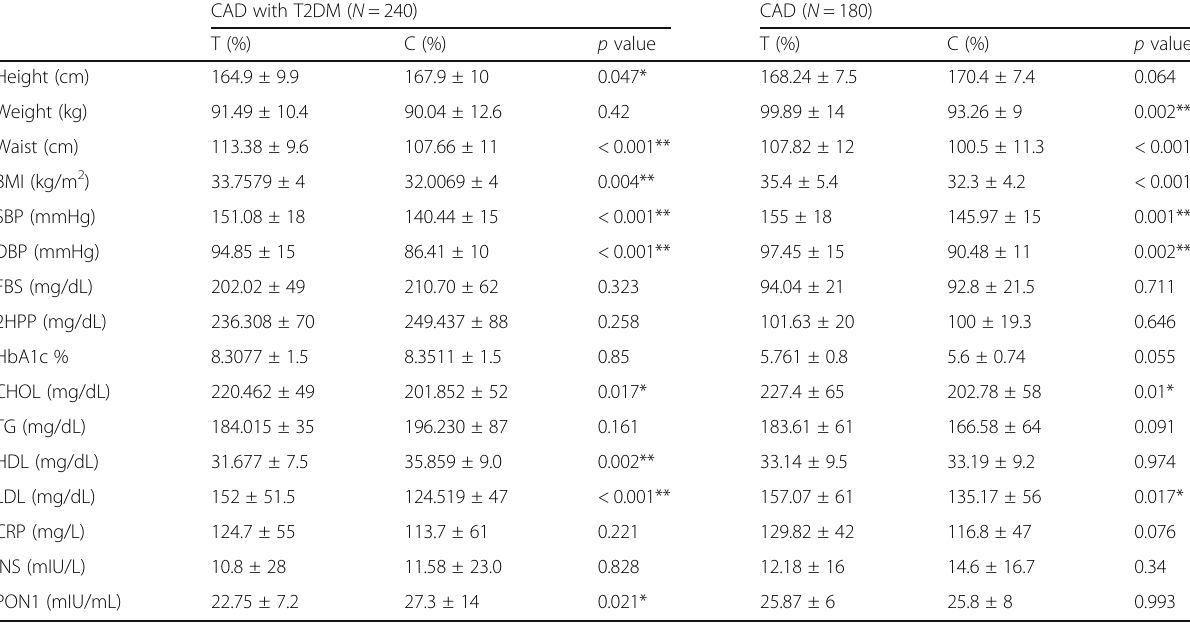
Table 4 GLUL polymorphism rs10911021 and characteristics of subjects among the studied groups CAD with T2DM ( N =